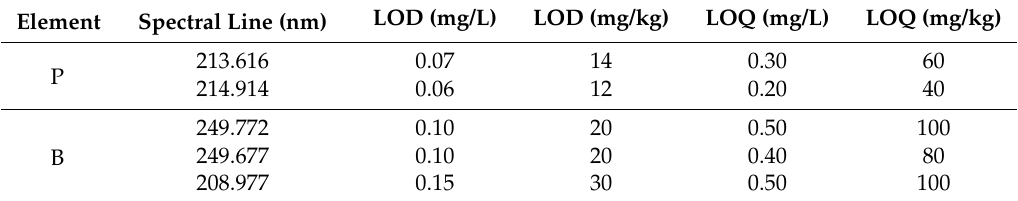
Table 7. Detection and quantification limits using a constitutive blank of 3 mL HCl + 1 mL HNO 3 . LODs and LOQs were calculated as described in Section 3.2.